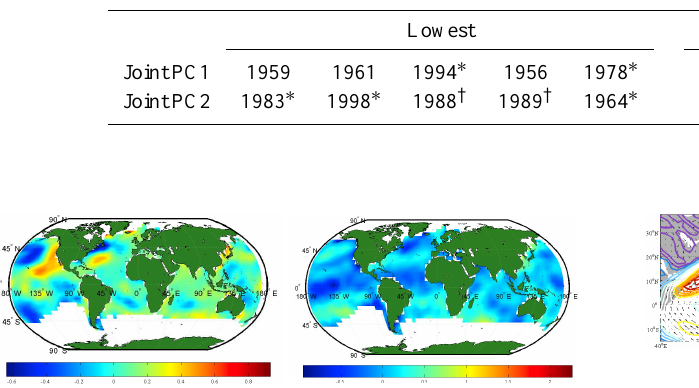
Table 2. Five years with lowest joint PCs values and those with highest values. Years labeled by stars are El Nino years, and ones labeled by daggers are La Nina years.